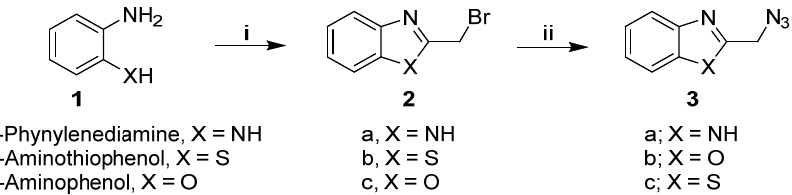
Figure 2. Preparation of 2-(azidomethyl)benzo[d]imidazole, 2-(azidomethyl)benzo[d]thiazole, and 2-(azidomethyl)benzo[d]oxazole. Synthetic procedures: (i) X = NH: bromoacetic acid, 4N HCl, reflux, 4 h, NH 4 OH; X = S or O: chloroacetyl chloride or bromoacetyl bromide, trimethylamine, xylene, 0 ◦ C for 2 h, reflux for 8 h. (ii) ethanol/DMSO/water (8:1:1), NaN 3 , 65–75 ◦ C, 7 h.